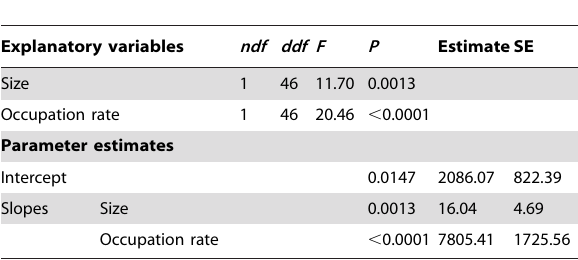
Table 2. Results of the multiple regression model testing for the effects of plant size and ant occupation rate on total leaf area.